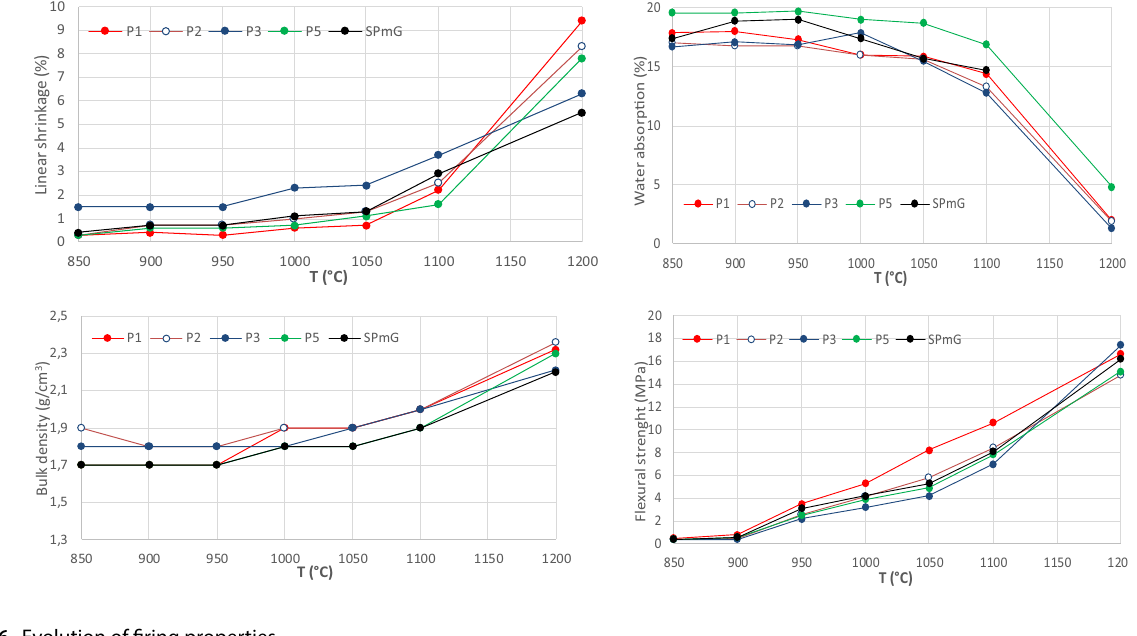
Fig. 6 Evolution of firing